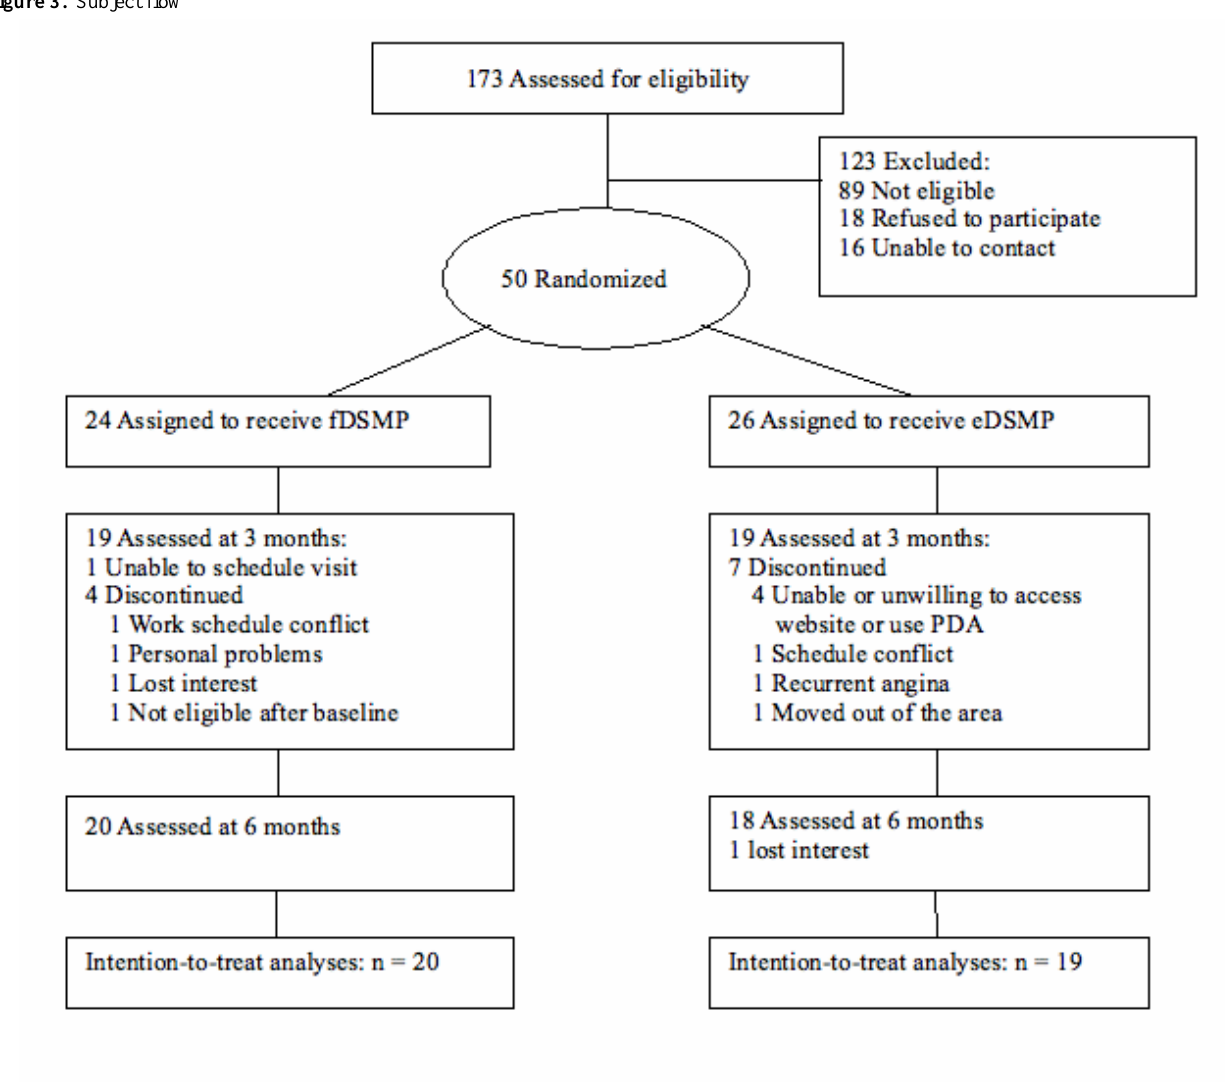
Figure 3. Subject